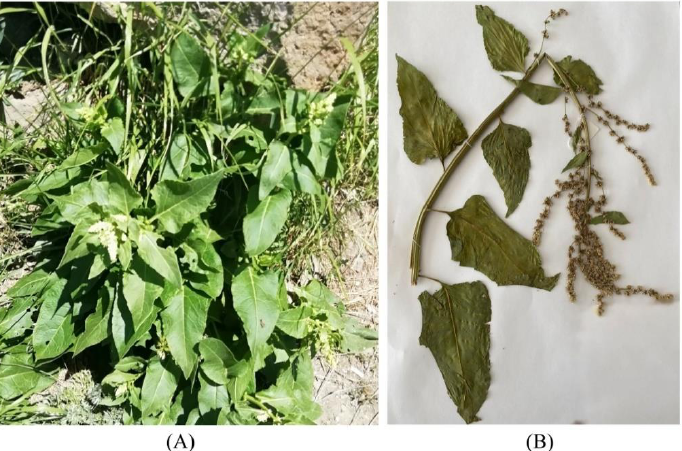
Figure 5. Beta macrorhiza species in their natural habitat ( A ) and a herbarium specimen ( B ). Vardenyats Mountain Pass (2410 m a.s.l.), Gegharkunik marz, RA, 12 July 2019. All of them refer to hemicryptophytes with annual monocyclic monocarpic shoots.